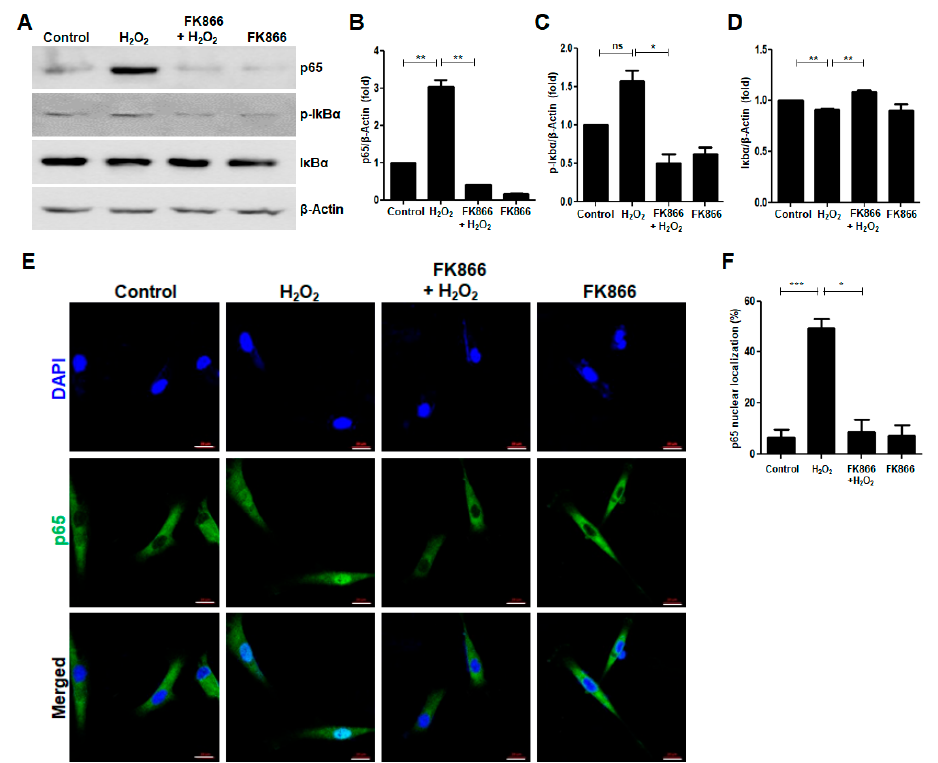
Figure 5. Effect of FK866 on H 2 O 2 -induced upregulation of NF- κ B p65 activation in hDPCs. The hDPCs were pretreated with FK866 (10 µ M) for 2 h and then stimulated with H 2 O 2 (400 nM) for 24 h. ( A ) The cell extracts were subjected to Western Blot analysis for detecting the expression of the NF- κ B p65, p-I κ B α , and I κ B α proteins. β -Actin was used as the loading control. ( B – D ) Densitometric analysis for assessing relative protein levels normalized to the levels of β -Actin: B, p65; C, p-I κ B α ; D, I κ B α . ( E ) Immunocytochemical analysis of NF- κ B p65 protein localization in the H 2 O 2 -treated cells. The cells were visualized using a fluorescence microscope. The nuclei were counterstained with DAPI (blue). ( F ) Quantitative results for the percentage of nuclear localization of NF- κ B p65. Scale bar: 20 µ m. * p < 0.1, ** p < 0.01, *** p < 0.001.